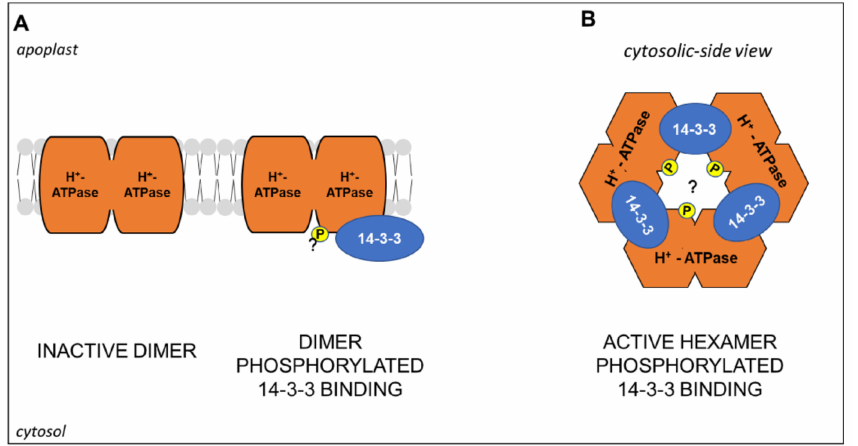
Figure 5. Schematic representation of ( A ) H + -ATPase/14-3-3 hexamer activation by an unknown kinase mediated-phosphorylation (“P”, yellow colored, question mark) and binding of 14-3-3 proteins. ( A ) Cytosolic-side view of the active hexameric complex. Model adapted from [159]. Further details are explained in the text. Table 2. Proteomic studies on plant responses to different N nutrient availabilities in roots. PepF: Peptide Fractionation. NO 3 − /NH 4+ indicates co-provision. The other acronyms are detailed in the text. Plant species are reported in subtitles. Proteome Major Results Fraction